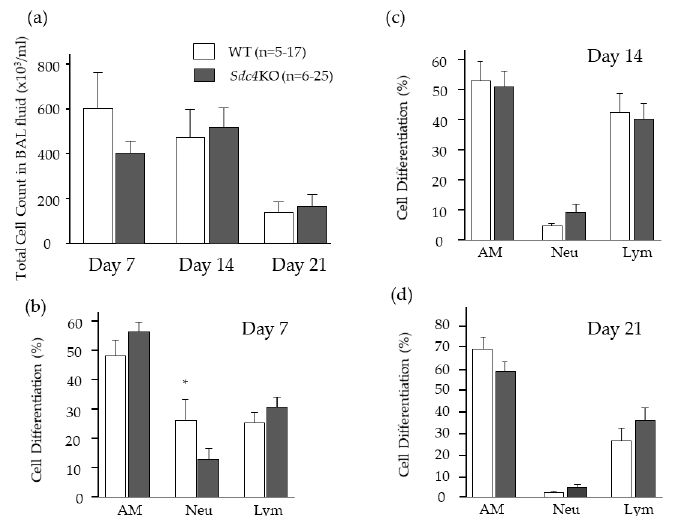
Figure 4. Bronchoalveolar lavage fluid findings after intratracheal bleomycin instillation. ( a ) Total cell count in BAL fluid did not di ff er between the wild-type (WT; n = 5–17) and syndecn-4-deficient ( Sdc4 KO; n = 6–25) mice at 7, 14 and 21 days after bleomycin instillation. ( b - d ) In addition, there was no di ff erence regarding the cell di ff erentiation in BAL fluid except neutrophils at seven days between the two groups. The di ff erence was compared using the Mann–Whitney U test. AM: alveolar macrophages, Neu: neutrophils, Lym: lymphocytes. *, p < 0.05 vs. Sdc4 KO.